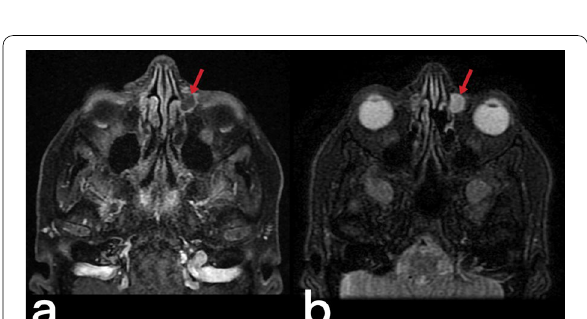
Fig. 14 A 28-year-old female patient. T1 weighted post-contrast image ( a ) and T2 weighted image ( b ) with a tuberculous abscess in the left lacrimal sac (arrows)